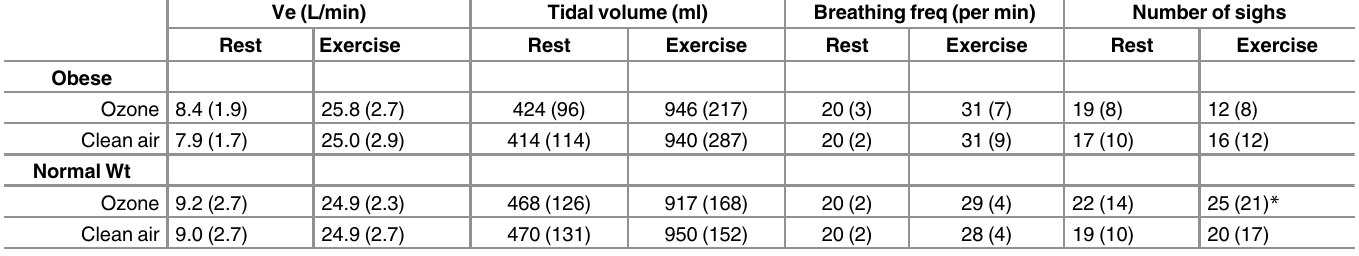
clean air and ozone exposure and each study group are shown in Table 4. There was no differ- ence in the number of responders (those subjects who demonstrated airway reactivity to methacholine in response to exposure) or in the PD20 for responders between the obese and normal weight subjects for either the ozone or clean air exposures. The obese subject who responded at 0.625 mg/ml after the clean air exposure was not challenged on the ozone expo- sure day for safety reasons. This subject ’ s FEV1 had decreased 30% immediately post-ozone exposure and had not returned to a greater than 70% predicted by 3 hours post-exposure (the assigned time for the methacholine challenge). For both study groups, those individuals who were responders post-clean air exposure were also responders after ozone exposure. The resting and exercise breathing parameters associated with the exposures are given in Table 5. The mean treadmill speed to achieve similar exercise minute ventilation in the normal vs. obese group was significantly different (3.3+/-0.3 vs. 2.4+/-0.4 mph respectively, p < 0.0001). There were no significant differences in breathing parameters between obese and normal weight subjects except for the number of sighs during exercise on the ozone exposure day, with significantly more sighs (two-fold) in the normal weight females. These sighs (at 2.5-fold the median tidal volume) during exercise are essentially inspiratory capacity (IC) breaths for each group. The number of coughs during the exposures was low and there were no differences between the two study groups during the ozone exposure, 2.6+/-5.4 (obese) and 4.9 +/-6.5 (normal weight). Only the normal weight group had increased cough frequency for ozone vs. clean air exposure (4.9+/-6.5 vs. 0.5+/-0.9 respectively, p < 0.01). These cough data were consistent with the post-ozone symptom reporting for cough severity. Table 5. Breathing patterns (mean (SD)) measured by respiratory inductance plethysmography. N = 18 for obese, one subject ’ s data was not recorded. Ve (L/min) Tidal volume (ml) Breathing freq (per min) Number of sighs Rest Exercise Rest Exercise Rest Exercise Rest Exercise Obese Ozone 8.4 (1.9) Clean air 7.9 (1.7) Normal Wt Ozone 9.2 (2.7) Clean air 9.0